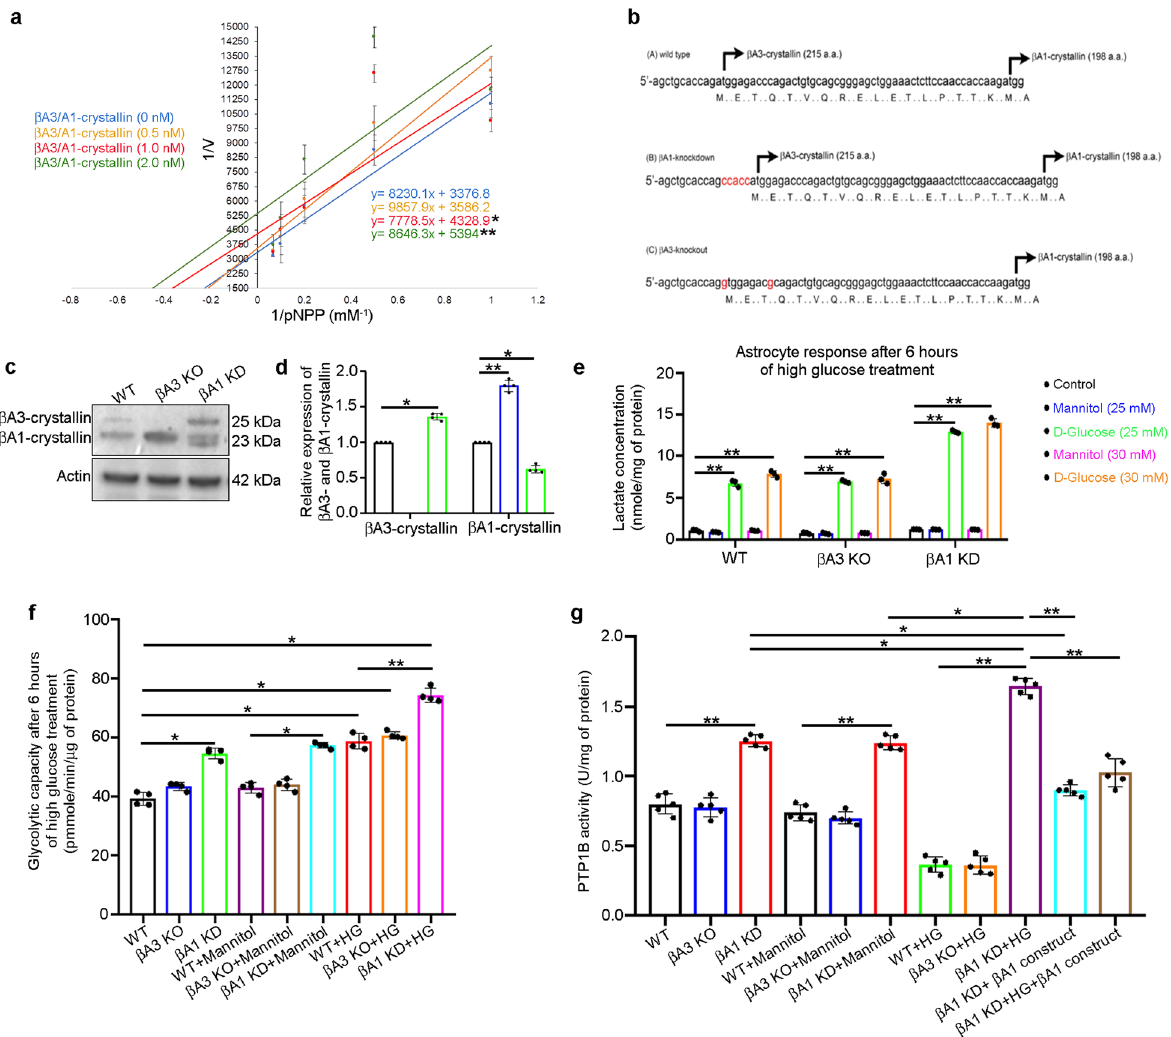
Fig. 2 β A1-crystallin regulates PTP1B activity. a Lineweaver-Burk plot showing increasing doses (0, 0.5, 1, and 2 nM) of β A3/A1-crystallin decreases both V K n = 3. * P < 0.05. ** P < 0.05. b The N-terminal sequence of max and M of PTP1B activity for different concentrations of p-Nitrophenyl Phosphate (pNPP). Cryba1 ; β A1-crystallin KD mice were generated by knocking in 5 base pairs (CCACC, red) before the fi rst start codon to strengthen the Kozak consensus sequence. For generating β A3-crystallin KO, the fi rst start codon was removed by a single nucleotide mutation in the mouse Cryba1 gene (A > G, red). Another silent mutation (C > G; red) was also introduced to prevent the binding and re-cutting of the sequence by gRNA after homology-directed repair. c Representative western blot and d graph showing densitometry analysis for the expression level of β A3/A1-crystallin in astrocyte lysates from WT (black bar), β A3 KO (blue bar), and β A1 KD (green bar) mice, respectively, showing complete loss of β A3-crystallin in the β A3 KO cells and a notable decrease in β A1-crystallin expression in the β A1 KD cells, relative to WT astrocytes. In β A3 KO astrocytes, there is an increase in expression of β A1-crystallin; n = 4. * P < 0.05, ** P < 0.01. e Increased levels of lactate in mouse WT, β A3 KO and β A1 KD astrocytes treated with HG (25 or 30 mM for 6 h) relative to untreated cells. Lactate levels in β A1 KD astrocytes were higher in all experimental conditions, compared to WT and β A3 KO cells; n = 3. * P < 0.05, ** P < 0.01. f Elevated glycolytic fl ux is evident from increased glycolytic capacity in WT, β A3 KO and β A1 KD astrocytes treated with high glucose (HG; 30 mM for 6 h), relative to untreated cells (cultured in 5 mM D -glucose containing medium). Glycolytic capacity in β A1 KD astrocytes was drastically higher compared to WT and β A3 KO cells; n = 4. * P < 0.05, ** P < 0.01. g Cultured β A1 astrocytes either untreated or exposed to mannitol (30 mM for 6 h) have elevated PTP1B activity compared to WT and β A3 KO cells, which increases further with HG (30 mM for 6 h). The elevation in PTP1B activity was